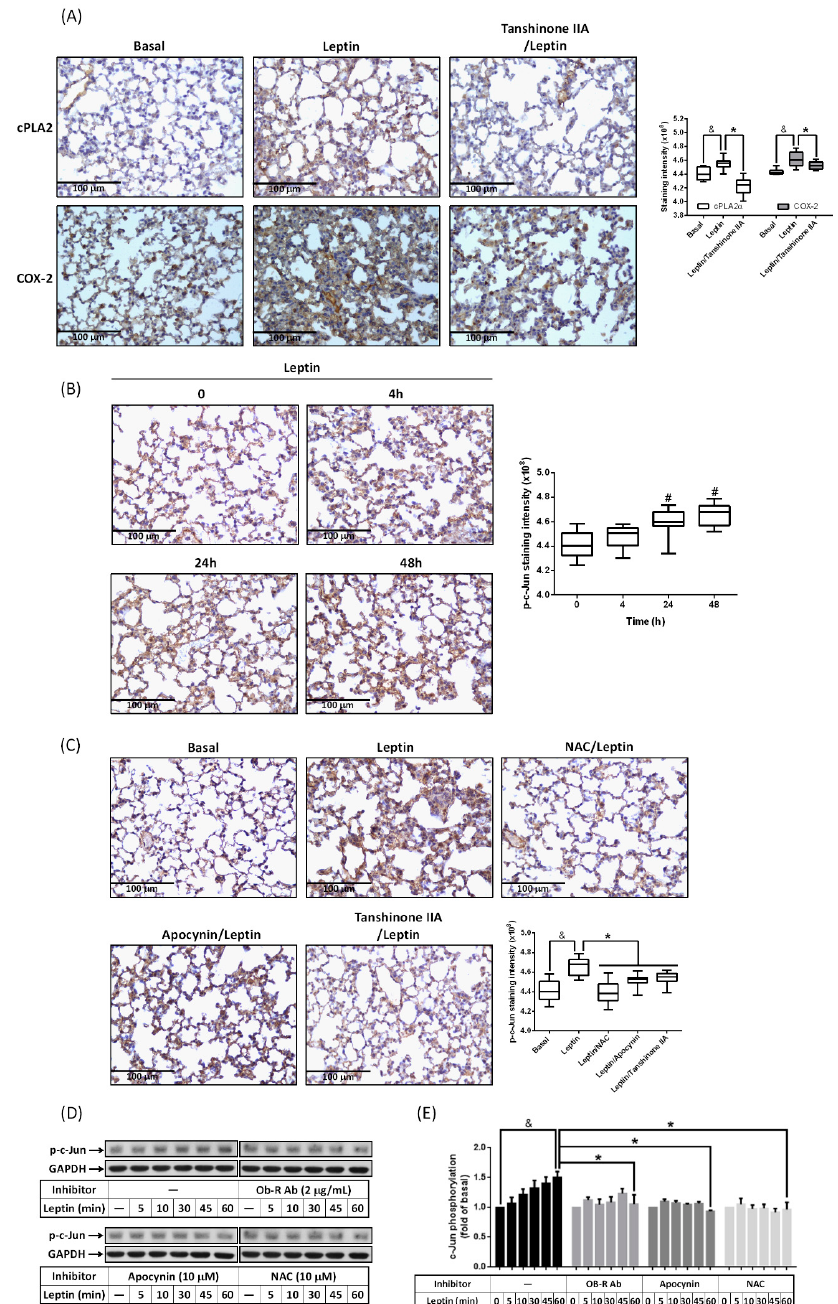
Figure 4. Involvement of AP-1 in leptin-stimulated cPLA 2 and COX-2 expression. ICR mice were i.t. injected with 2 mg/Kg of leptin for the indicated time intervals. Alternatively, mice were i.p. injected with 2 mg/Kg of tanshinone IIA for 1 h then i.t. injected with 2 mg/Kg of leptin for 48 h. ( A ) Expression of cPLA2 ( top ) or COX-2 ( bottom ) and ( B , C ) phosphorylation of c-Jun were detected by IHC. The staining intensity of IHC data is shown as box plots summarizing the median, 25th and 75th percentiles, whiskers, and outliers. A549 cells were pretreated with or without the OB-R antibody (2 µ g/mL), NAC (10 µ M), or apocynin (10 µ M) for 1 h and then stimulated with leptin (1 µ g/mL) for the indicated time intervals. ( D ) Phosphorylation of c-Jun (a subunit of AP-1) was detected by Western blot. ( E ) Phosphorylation levels of c-Jun are shown as the mean ± SEM of five independent experiments. # p < 0.05 as compared with the group of 0 min. & p < 0.05 or * p < 0.05 as compared between the two indicated